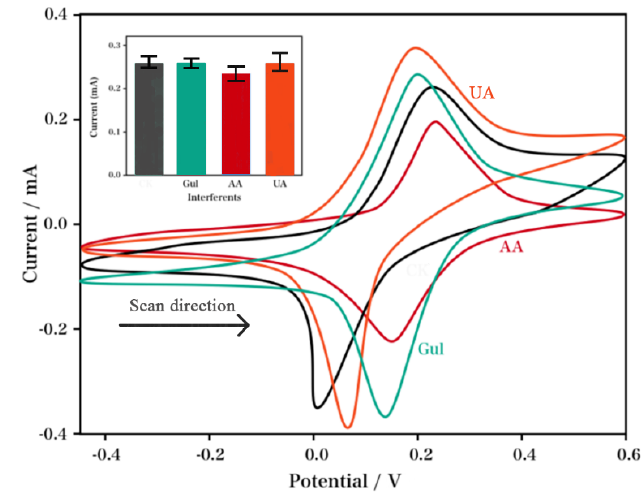
Figure 4. Interfering effects of uric acid (UA), ascorbic acid (AA) and glucose (Glu) on the performance of CPE/TiO 2 /(CS+AuNPs)/anti-ProGRP/BSA/ProGRP, with the histogram plot with these interference agents shown in the inset.